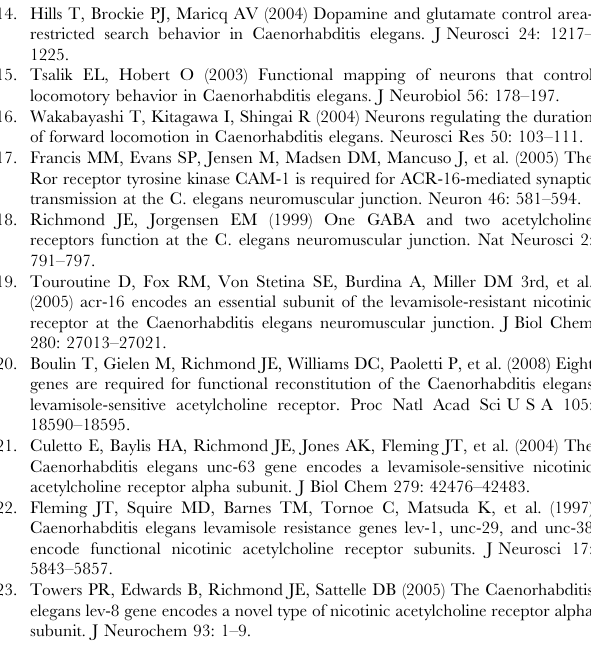
Figure S6 L-AChR( gf ) expression prolongs the slow L-AChR mediated component of synaptic currents. ( A ) Representative muscle current responses to photostimulation of excitatory motor neurons recorded from adult control (n= 10) or L-AChR (gf) (n= 7) animals. Black bar indicates duration of motor neuron photostimulation (10 ms). Holding potential was 2 80 mV. ( B, C ) Average amplitude (B) and decay time (C) of photoevoked currents. Currents were fit with two exponentials ( t 1 and t 2) to account for slow and fast currents associated with synaptic activation of L-AChR and N-AChR respectively. Both strains stably express the Pacr-2::ChR2-GFP transgene ( ufIs23 ). (PDF) Text S1 Detailed cloning information for